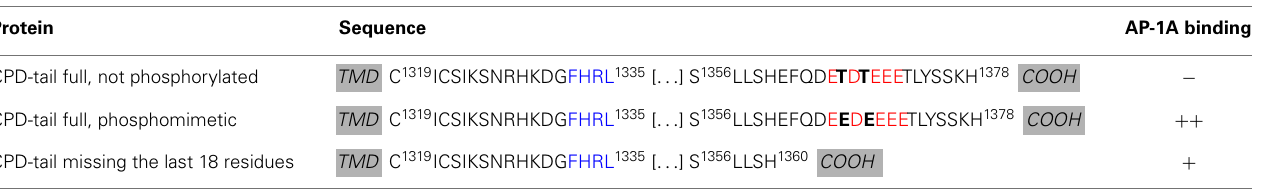
Table 2 | Summary of mutational analysis of CPD